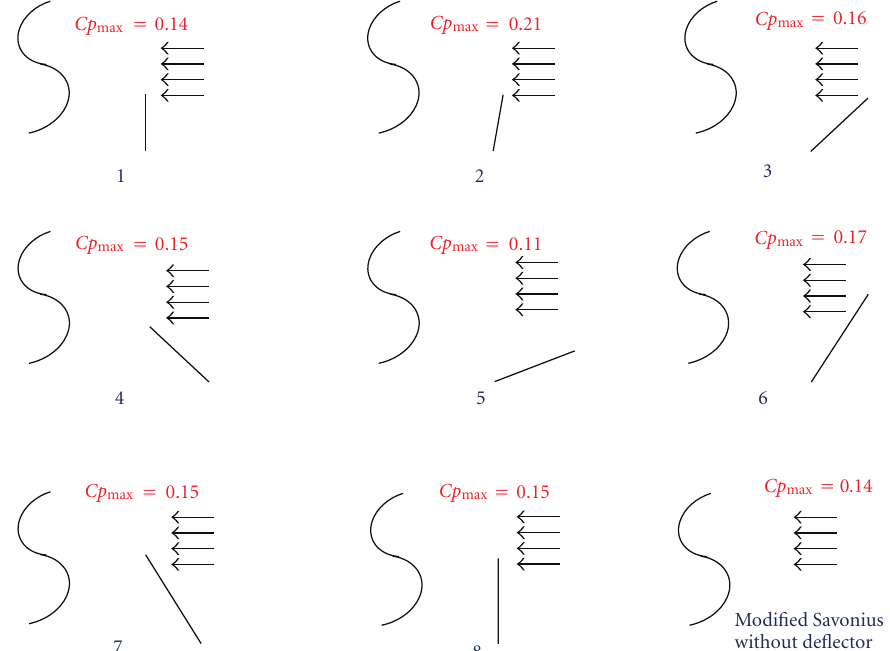
Figure 6: Di ff erent positioning of deflector plate on the returning blade side with respect to modified Savonius rotor and corresponding [12]. Cp max